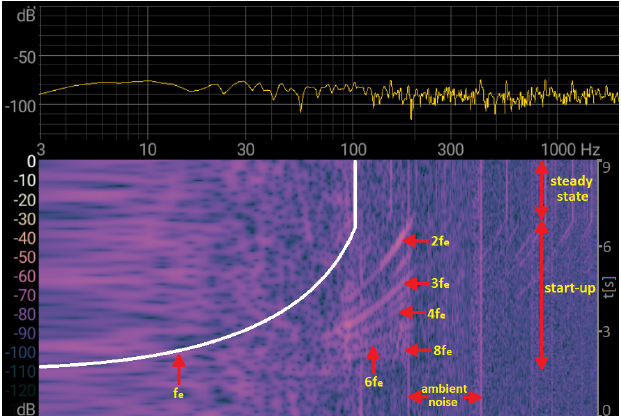
Figure 20. Sound spectrogram measured during start-up ( ω e from 0 to 640 rad (2nd + 6th harmonic) + CHC are applied. Speed ramp 300 rpm